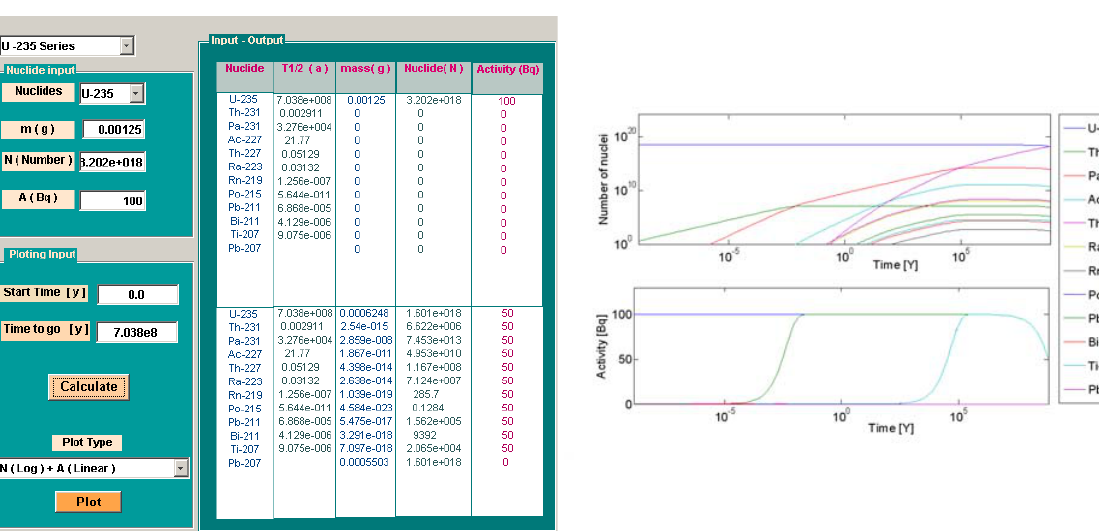
Fig. 3 Example of operation for the 235 U decay chain with initial activity 100 Bq. Decay time is the half-life of 235 U.